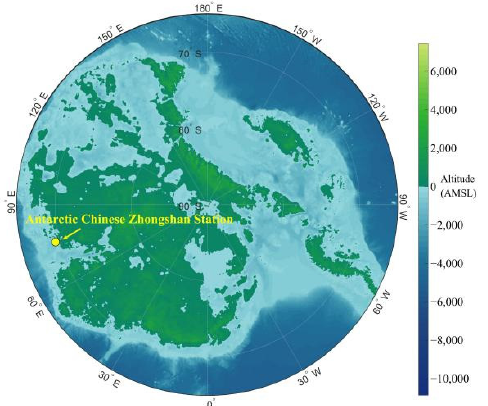
Figure 1. Location of the Antarctic Chinese Zhongshan Station (the yellow dot represents the location of Antarctic Chinese Zhongshan Station, and the colors [from blue to green] represent different altitudes [above mean sea level]).